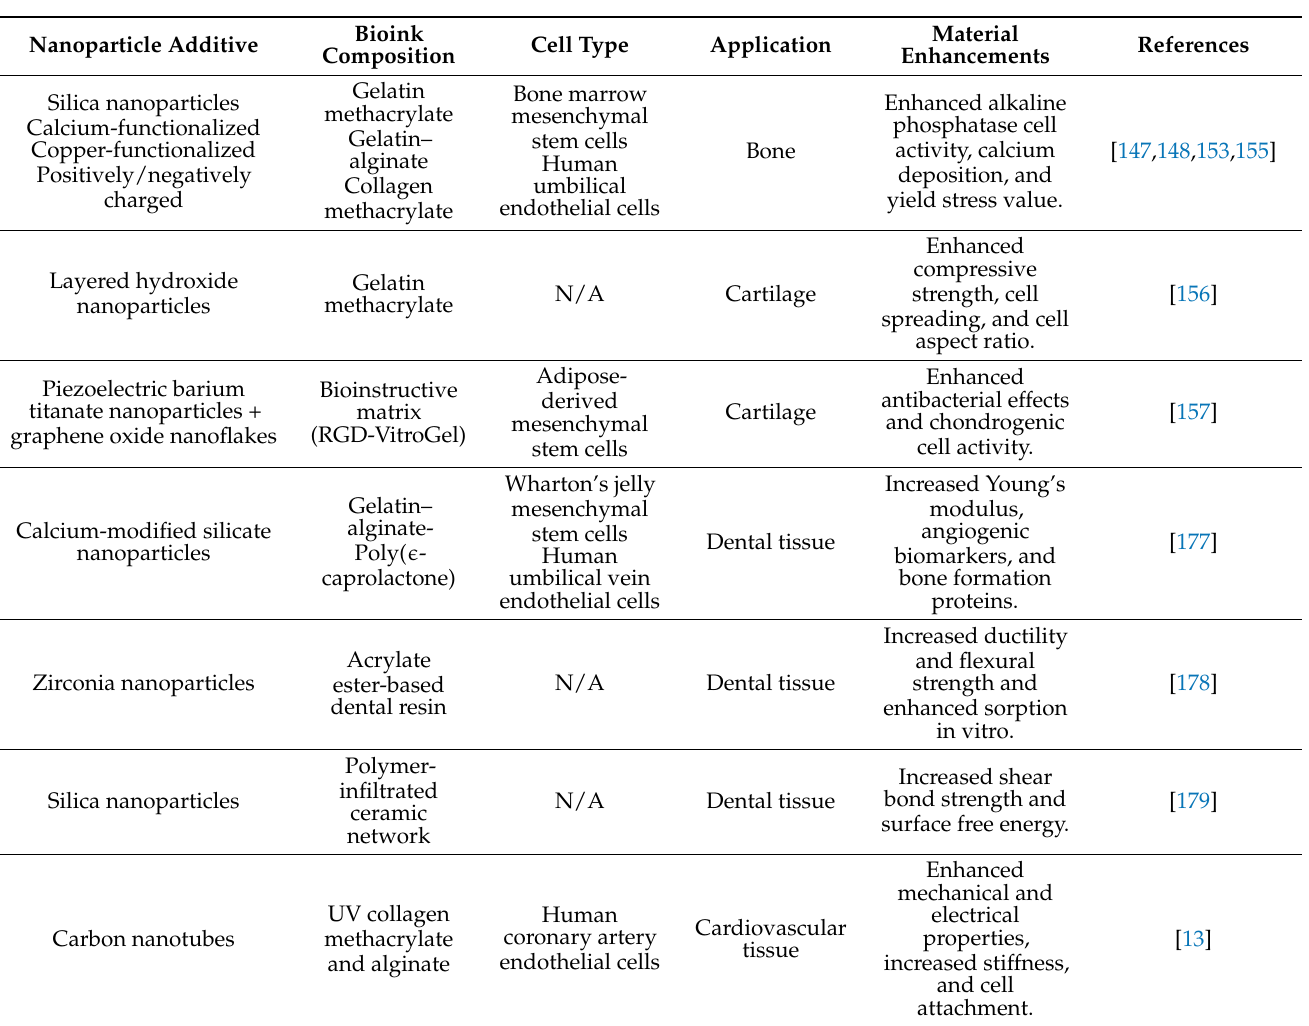
Table 2. Representative nanoparticle composite inks and associated enhancements on 3D-printed scaffolds for tissue engineering